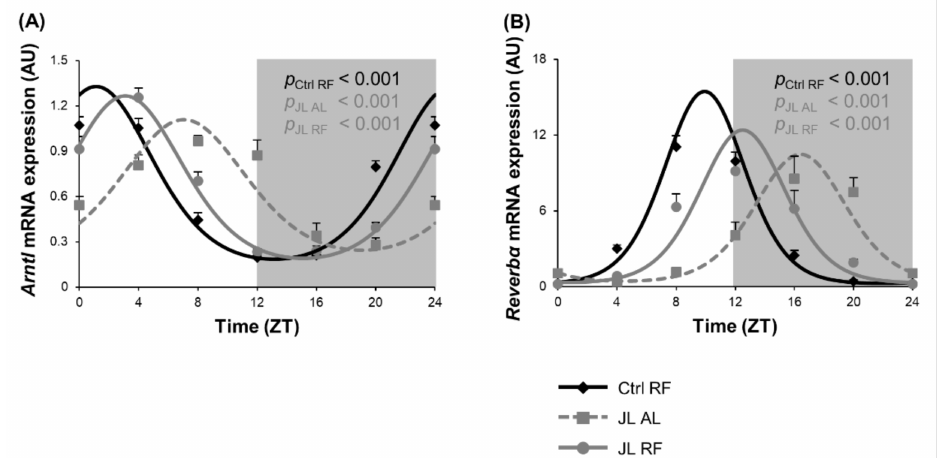
Figure 7. Effect of time restricted feeding on clock gene mRNA expression in the colonic mucosa. ( A ) Arntl and ( B ) Reverb α mRNA expression in the mouse distal colonic mucosa of control mice fed a TRF diet (Ctrl RF), jetlagged mice fed ad libitum (JL AL) and jetlagged mice fed a TRF diet (JL RF) (N = 8mice per time point per group). The fitted cosine curve determined by cosinor analysis (period = 24 h) are shown in Ctrl RF, JL AL and JL RF mice. The dark phase is shaded grey. Statistics: Non-linear regression (Proc NLIN). p -values refer to probability values for the best fitting cosine